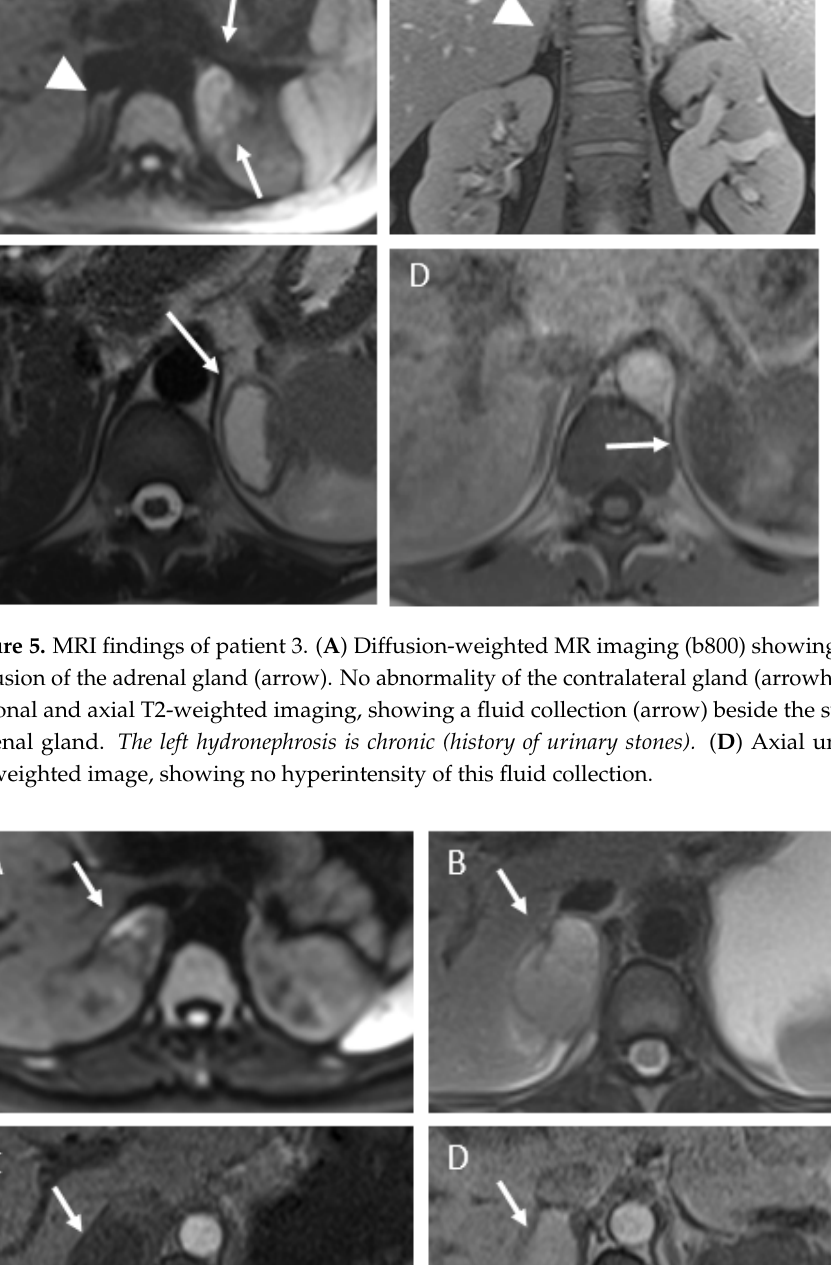
Figure 4. MRI findings of patient 3. ( A , B ) T2-weighted MR imaging, coronal ( A ) and axial ( B ) planes showing edema of the right adrenal gland (arrow) and adjacent fat. No abnormality of the contralateral gland (arrowhead). ( C ) Unenhanced axial T1-weighted imaging showing no hyperintensity of the adrenal gland (arrow). ( D ) Diffusion-weighted MR imaging (b800) showing restricted diffusion of the adrenal gland (arrow).